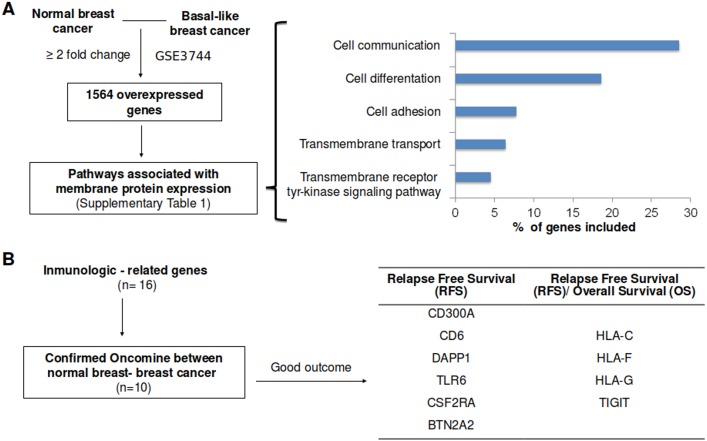
Gene-set enrichment analyses of differentially expressed genes between normal breast and basal like breast cancer, and association with clinical outcome.A. Overexpressed genes with a minimum of two fold-change difference between normal breast and basal-like breast cancer (left side), as described in material and methods. Using functional annotation, only genes associated with functions linked with cell membrane proteins were included (right side). B. Identification of immunologic related genes included in the identified functions (16 genes). Selection of genes which upregulation was confirmed using data contained at Oncomine (10 genes) and linked with outcome. Outcome screening analyses for RFS and OS using the KMplotter online tool for those ten identified genes.